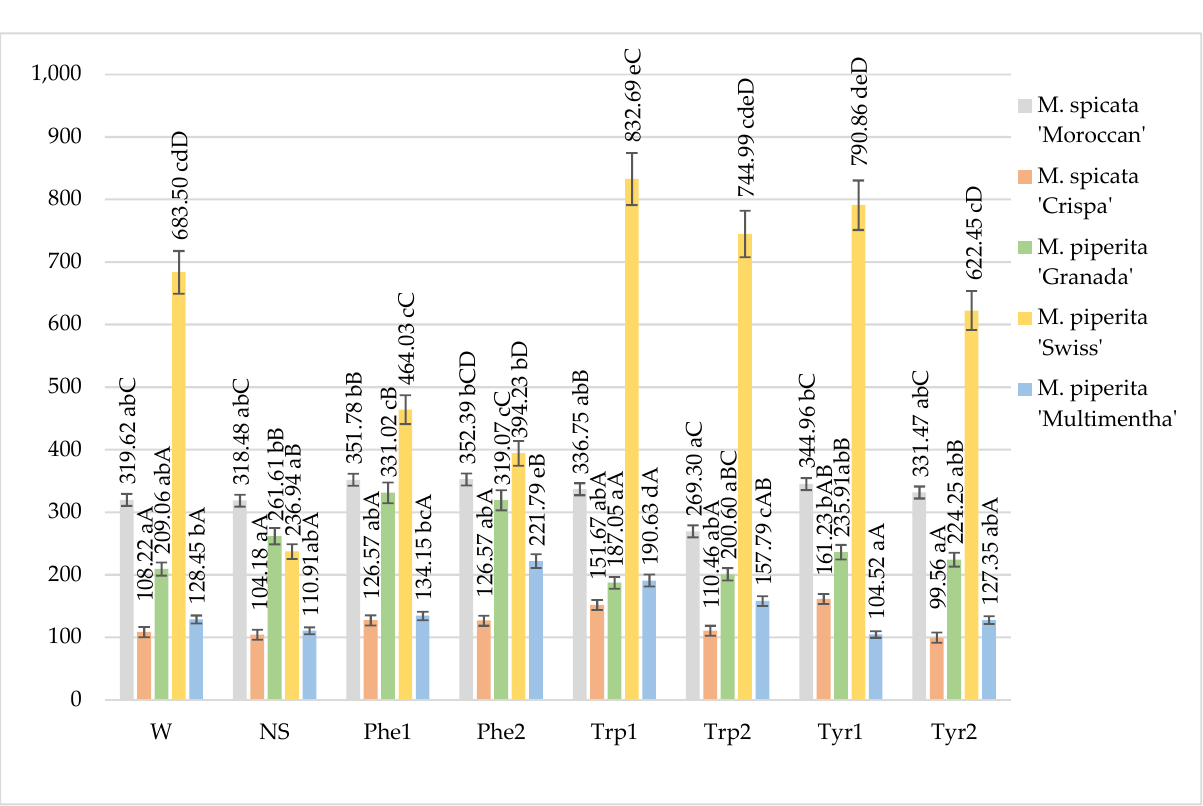
Figure 1. Total phenols content in mints influenced by foliar application of amino acids, mg 100 g −1 DM in 2017–2018 (W—water, NS—non sprayed, Phe1—phenylalanine 100 mg L −1 , Phe2—phenylalanine 200 mg L −1 , Trp1—tryptophane 100 mg L −1 , Trp2—tryptophane 200 mg L −1 , Tyr1—tyrosine 100 mg L −1 , Tyr2—tyrosine 200 mg L −1 ; Means marked with different upper letters (A, B, C…) indicate significant difference between varieties at p < 0.05; Means marked with different lower letters (a, b, c…) indicate significant difference between foliar application with amino acids at p < 0.05).